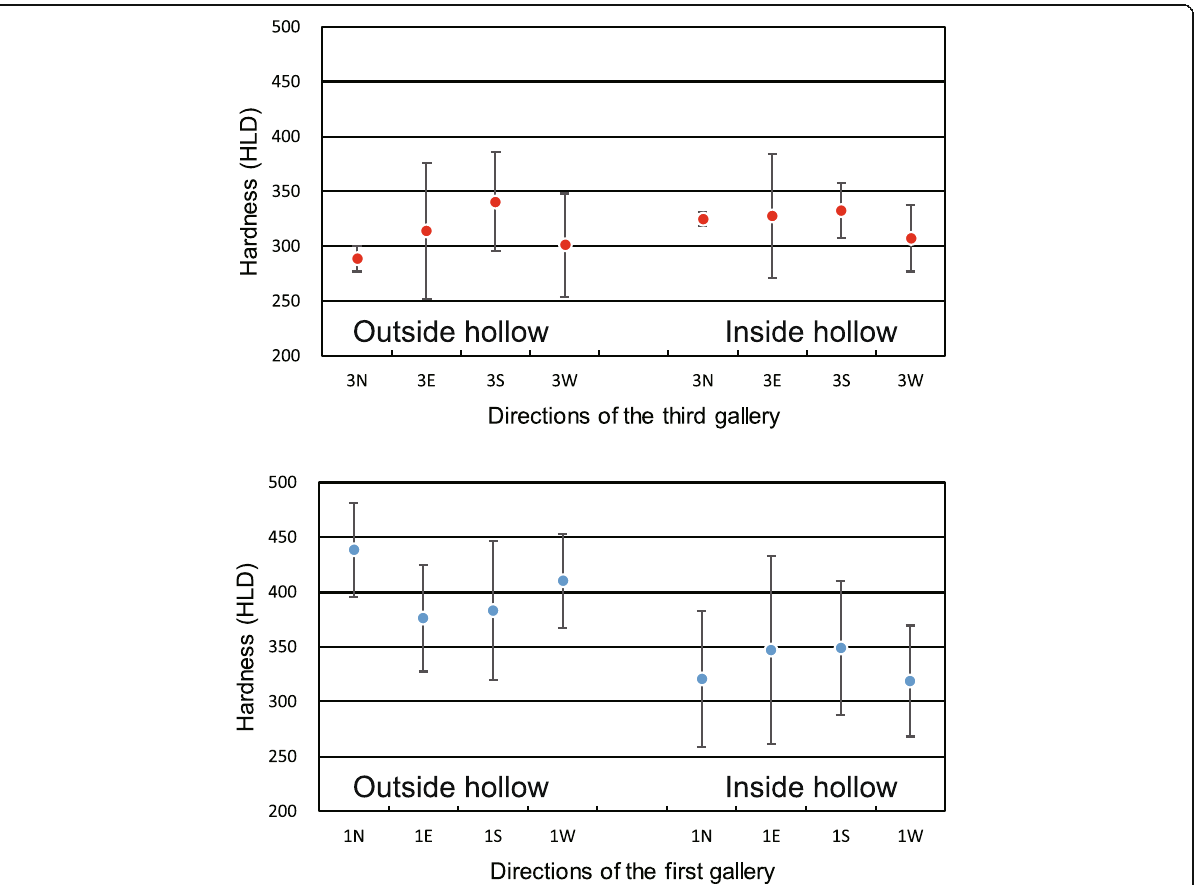
Fig. 6 Relationships between the hardness of the hollow and gallery directions. Bars indicate the standard deviation of